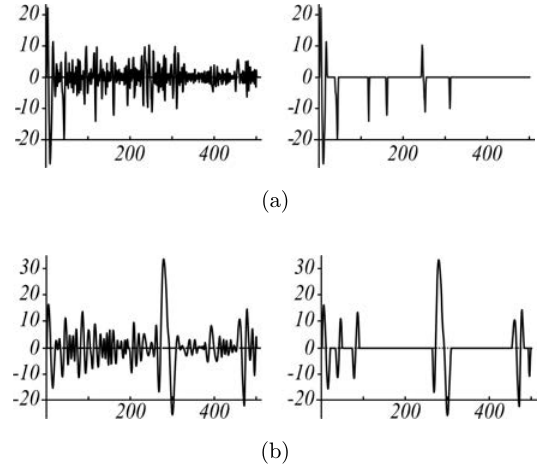
Fig. 1. Demo of proposed threshold technique: (a) IMF c 1 ð j Þ and(b) c 2 ð j Þ before(left)andafter(right)thresholding( T ¼ 10).